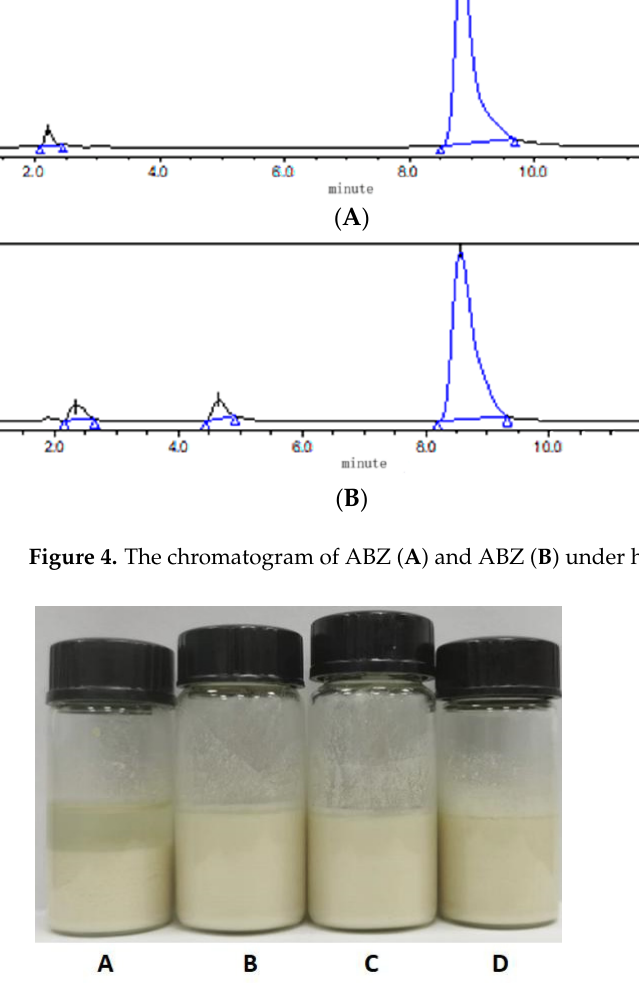
Figure 4. The chromatogram of ABZ ( A ) and ABZ ( B ) under high temperature of 90 °C.